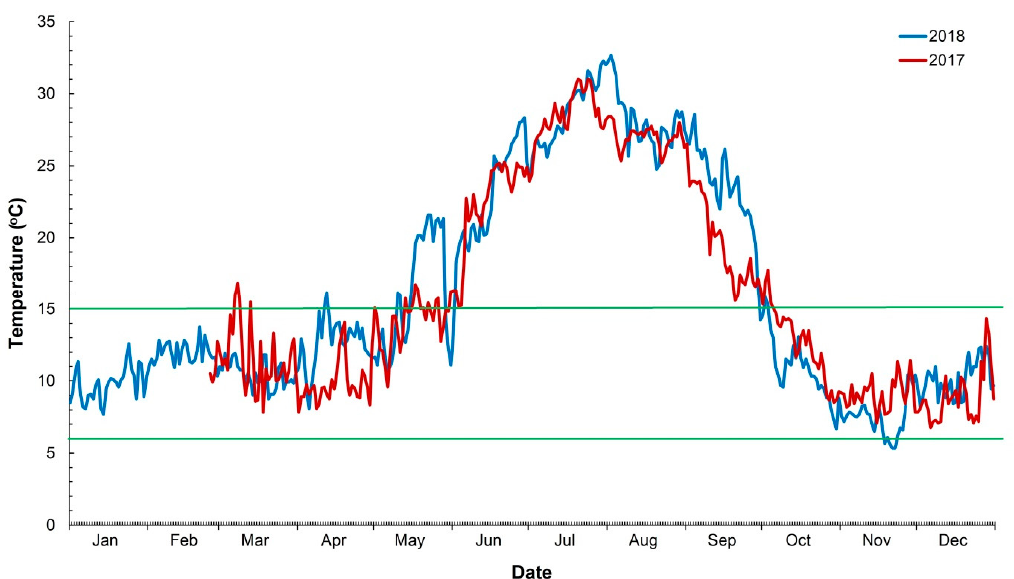
Figure 2. The mean water temperature in the manmade channel of the Arkhangelsk Thermal Power Plant (TPP). The green lines indicate the range of minimum temperature for breeding Corbicula sp. from +6 to +15 °C [7].